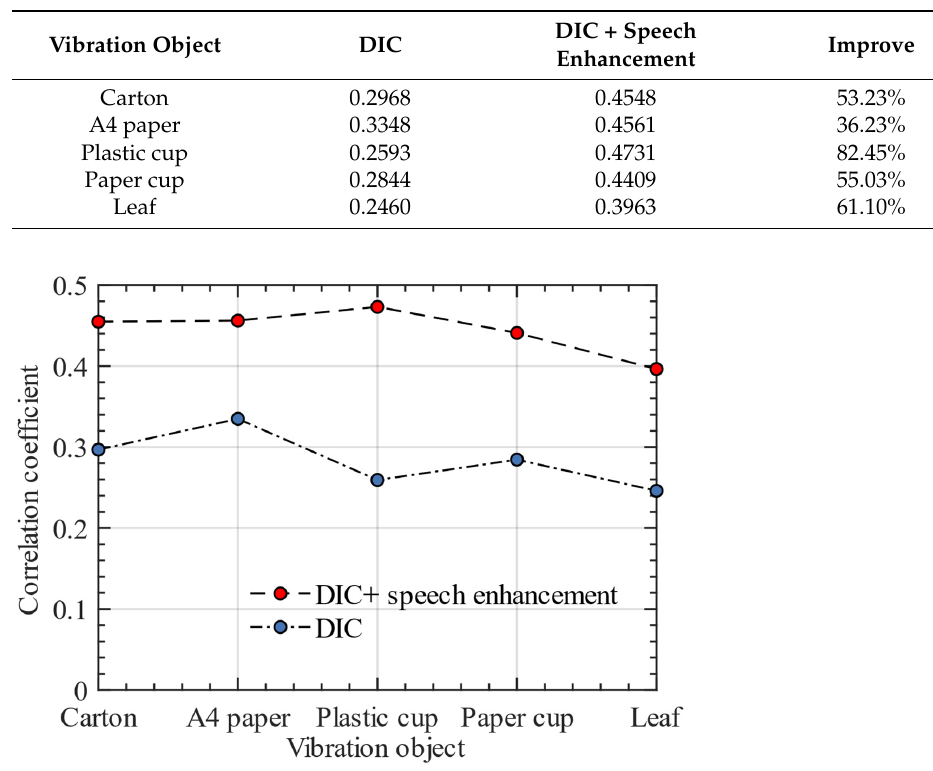
Table 7. Comparison of sinusoidal signal reconstruction accuracy.